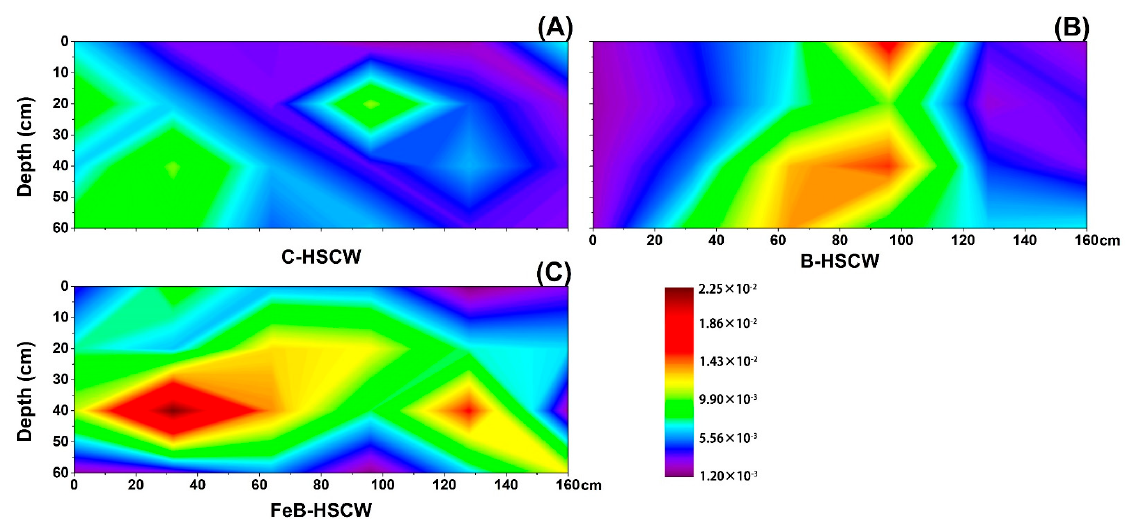
Figure 8. The spatial distribution of qnorB relative abundance in C-HSCW ( A ), B-HSCW ( B ), and FeB-HSCW ( C ) based on interpolated maps. Color scales indicate extrapolated values by kriging. C-HSCW, without biochar and FeB-modified biochar; B-HSCW, with biochar; FeB-HSCW, with FeB-modified biochar.